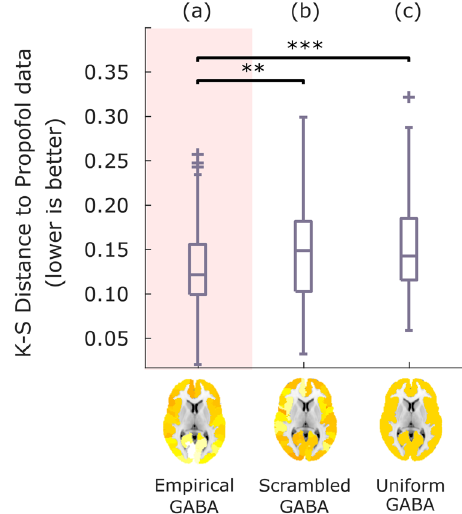
Fig. 3 Modulation of inhibitory gain by reshuf fl ed or uniform GABA-A receptor density. After identifying the value of s I that leads to the best fi t with the empirical propofol data when modulating the inhibitory gain of each node in the balanced DMF model according to the empirical distribution of GABA-A receptors ( a ), the simulation is repeated after randomly reshuf fl ing the regional receptor densities across the cortex ( b ), or setting them all to a uniform value (mean of the empirical distribution) ( c ). Box-plots show the model fi t to the propofol data for n = 100 simulations, quanti fi ed as KS-distance (lower is better) between simulated and empirical FCD, for each variant of the model. Middle line: median; box limits, upper and lower quartiles; whiskers, 1.5x inter-quartile range; “ + ” symbol indicates outliers; ** p < 0.01; *** p < 0.001 from t -test. Source data are provided in Supplementary Data 1. We replicated this result using an alternative version of the KS-distance, which in addition to the distribution of FCD values also takes into account the temporal lag between them (Supplementary Fig.